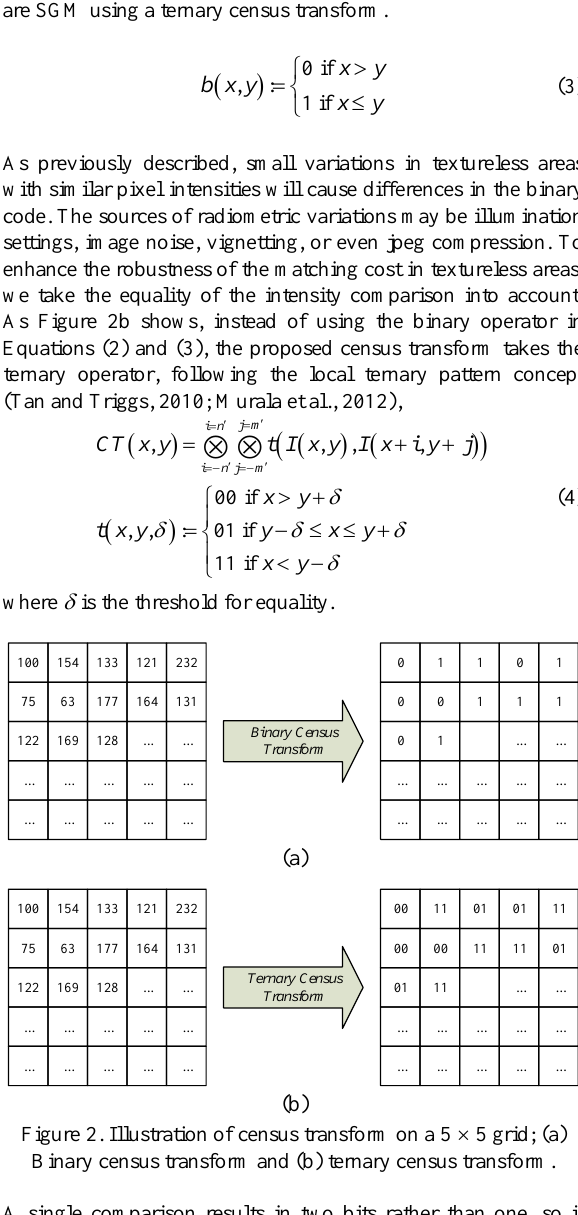
Figure 3. This sparse and symmetrical pattern has two possible advantages: 1) a dense grid may have a close correlation between adjacent pixels, and 2) the pattern is designed to follow the Gaussian kernel, thus giving more weight to pixels close to the center. As only 32 grids are used for the evaluation, the total length for a single pixel is 64-bit and the matching cost can be evaluated in a single